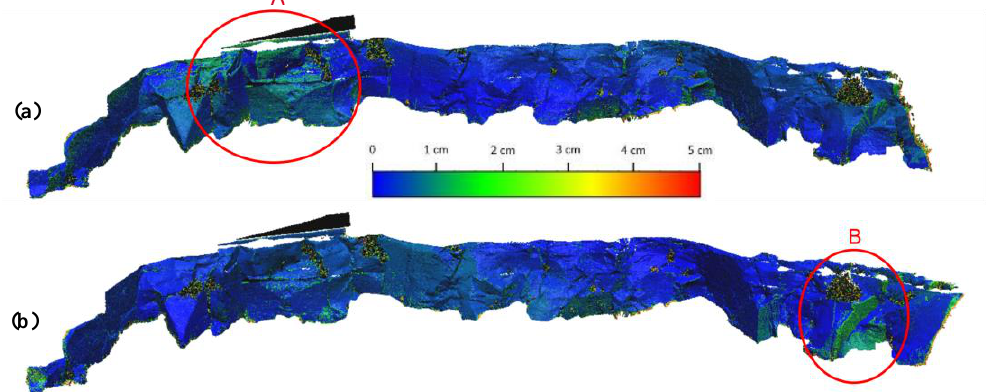
Figure 7. Error mapping of the deviation between (a) TSL and model P3-PS-Target-MCS and (b) TSL and model P3-PS-Target- SCS.